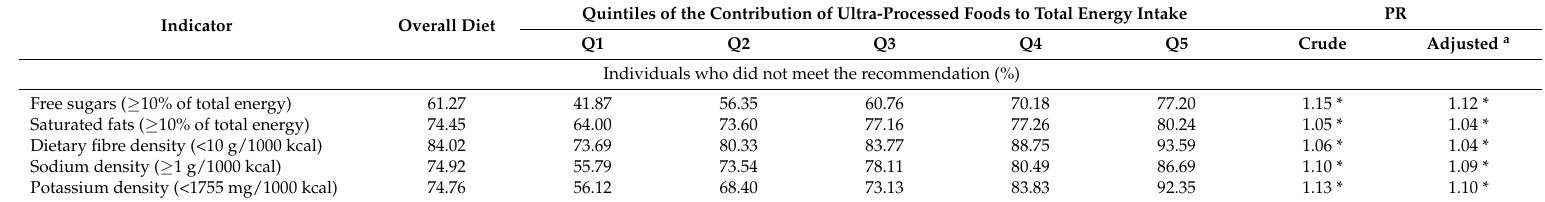
Table 4. Prevalence of inadequate nutrient intake across strata of increasing ultra-processed food consumption. UK population aged 1.5 years or over (2008–2014).